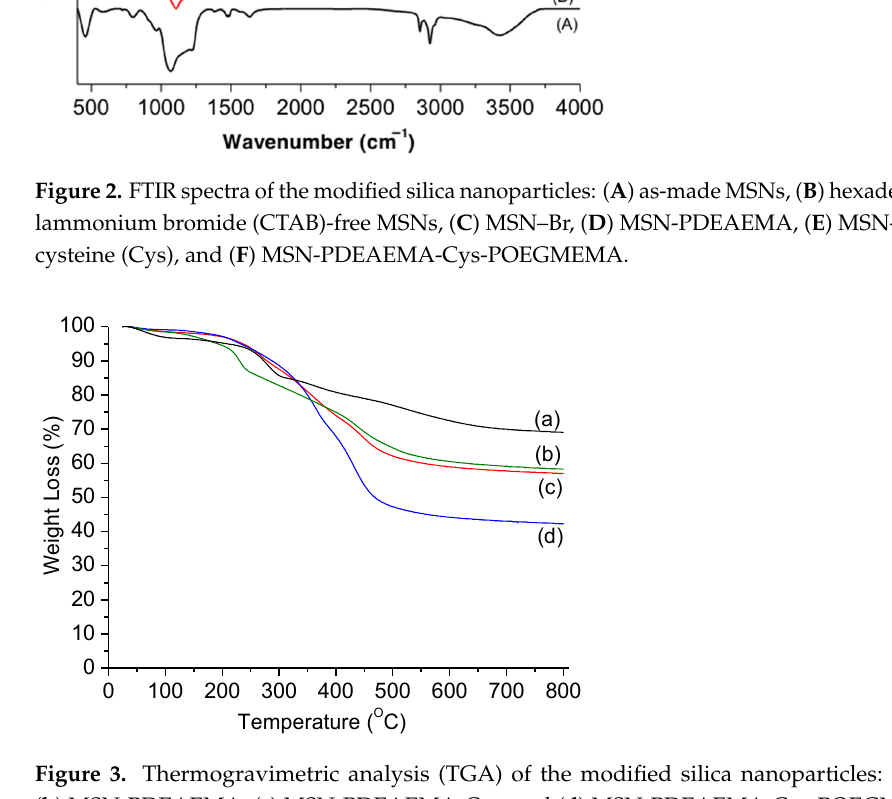
Figure 2 . FTIR spectra of the modified silica nanoparticles: ( A ) as-made MSNs, ( B ) hexadecyltri- methylammonium bromide (CTAB)-free MSNs, ( C ) MSN–Br, ( D ) MSN-PDEAEMA, ( E ) MSN- PDEAEMA-cysteine (Cys), and ( F ) MSN-PDEAEMA-Cys-POEGMEMA.